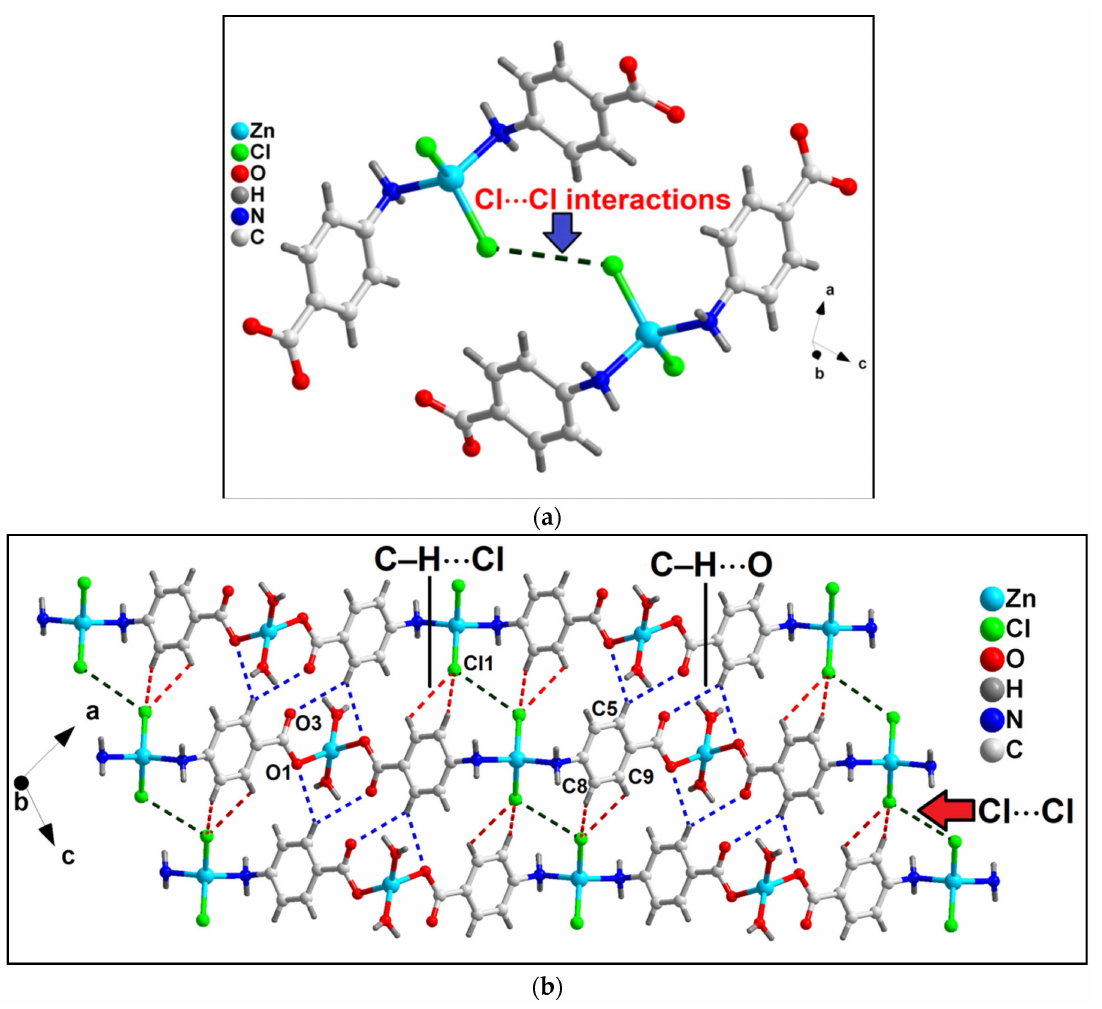
Figure 2. ( a ) Unconventional Type I Cl · · · Cl interactions observed in compound 1 ; ( b ) 2D network architecture of compound 1 along the crystallographic ac plane aided by intermolecular C–H · · ·